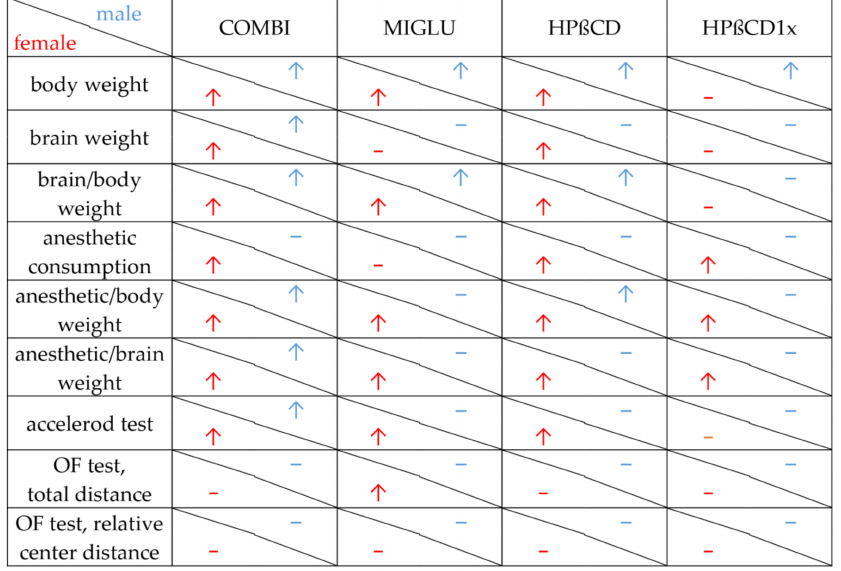
Figure 8. Changes, induced by COMBI, MIGLU, HPßCD and HPßCD1x in NPC1 − / − mice. Significant amelioration ( ↑ ) or no significant change ( − ) compared with the respective None and/or Sham groups. Apart from body weight data, all other data shown here are